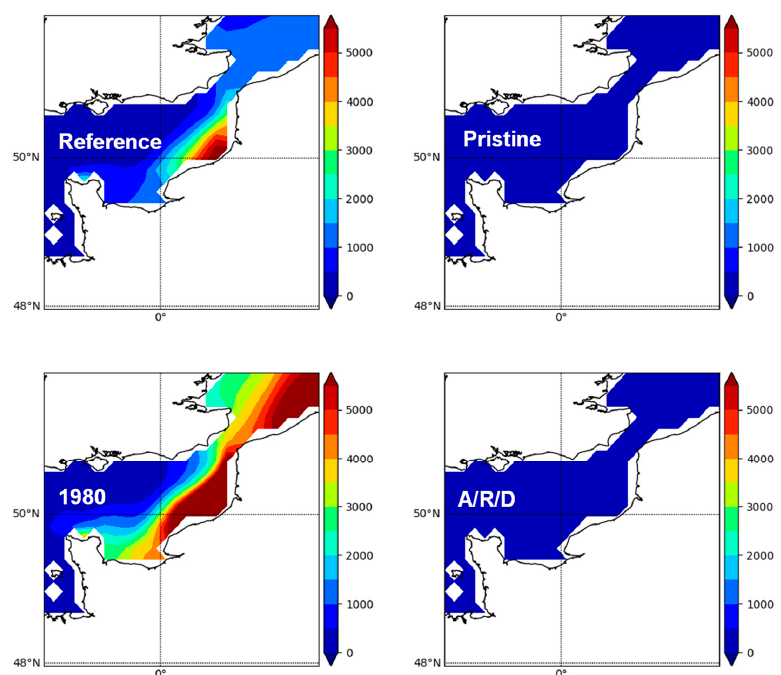
Figure 10. Comparison of the geographical distributions of cumulated concentration of domoic acid (over the period studied) simulated by the ECO-MARS3D model under the reference situation and the three contrasted scenarios.